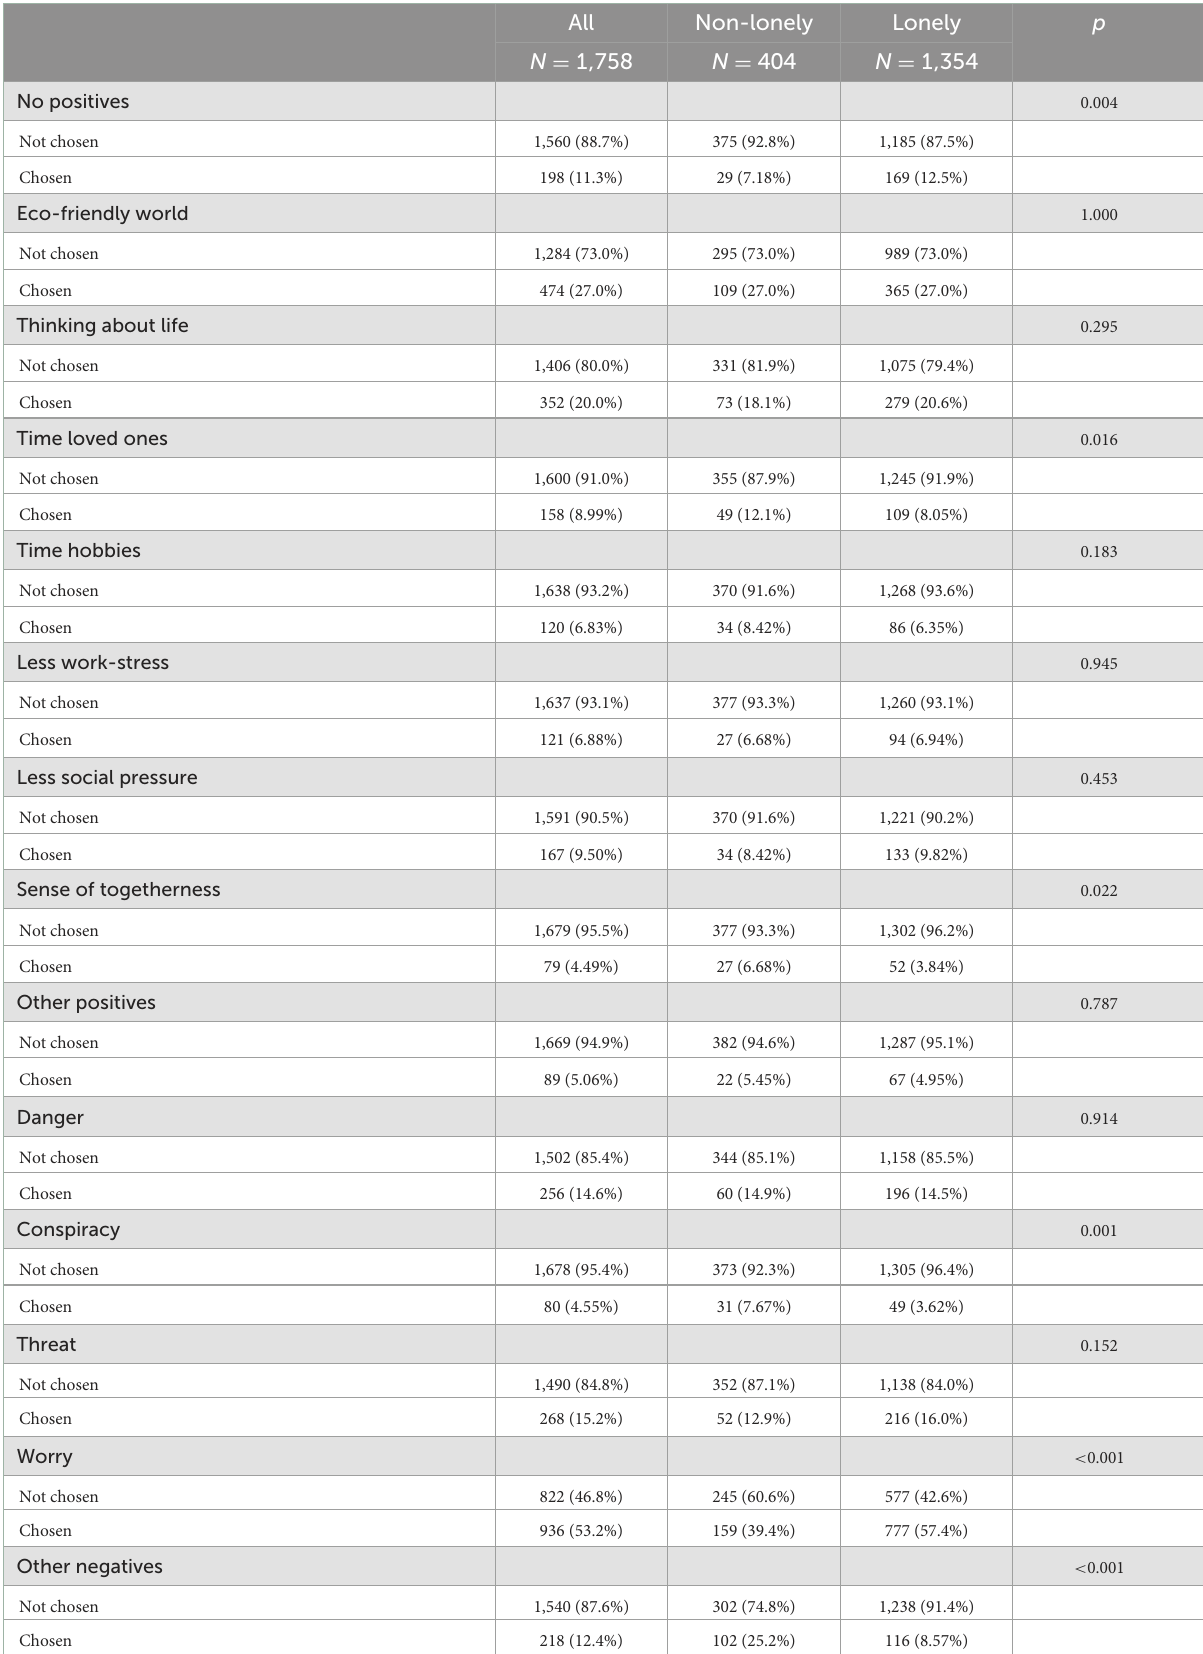
TABLE 2 Differences in positive and negative experiences of living in the COVID-19 pandemic among lonely and non-lonely individuals. All Non-lonely Lonely p N =